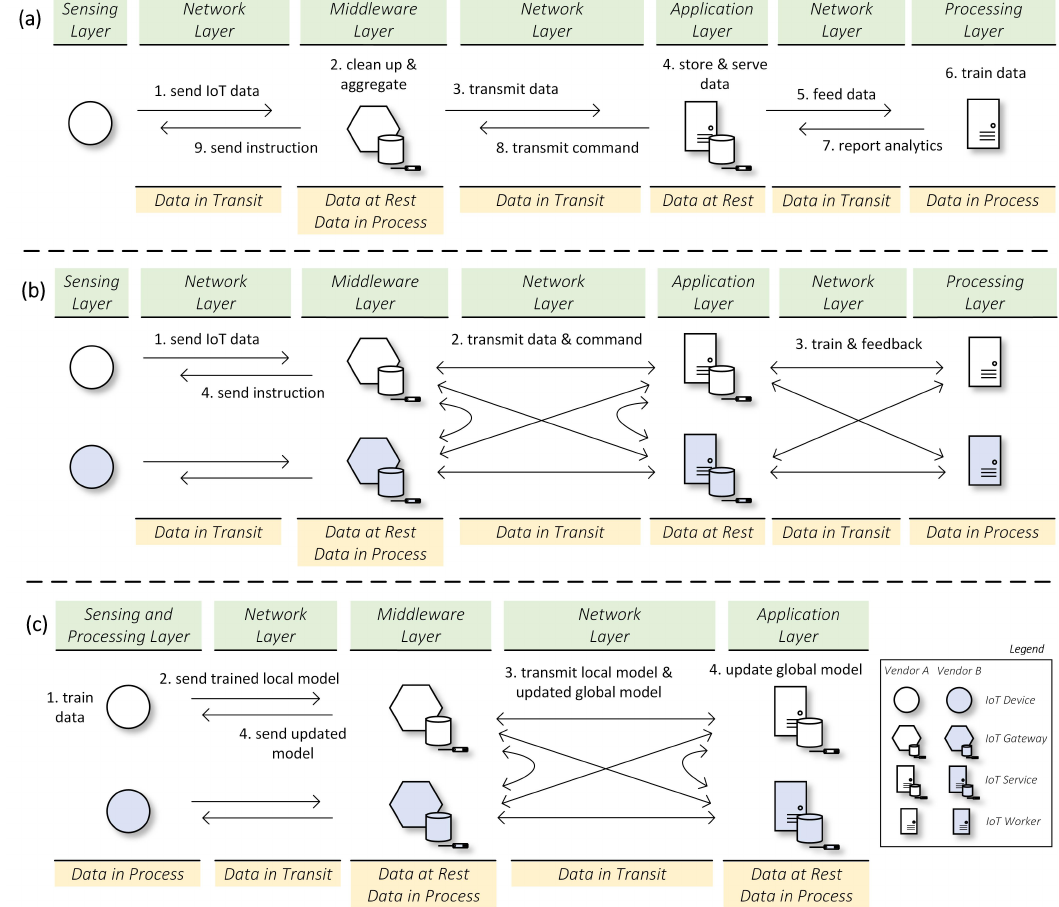
Figure 1. A general Internet of Things (IoT) data flow pipeline, which comprises of 5 layers (i.e., sensing, network, middleware, application, and processing layers) and 3 types of operations (i.e., data in transit, data at rest, and data in process). We present three IoT data flow pipeline scenarios: ( a ) the centralized IoT data flow pipeline, ( b ) the collaborative IoT data flow pipeline, and ( c ) the privacy-preserving IoT data flow